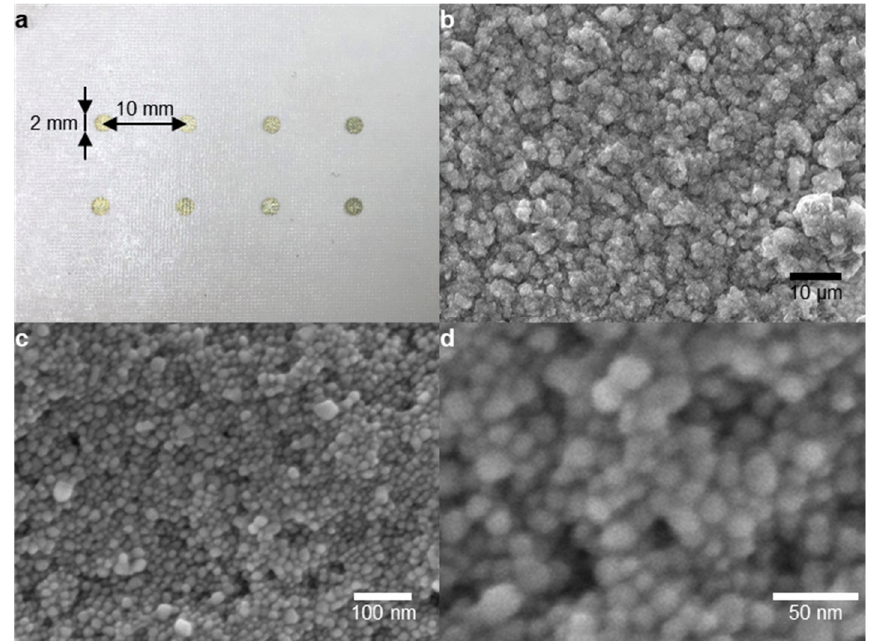
Figure 4. ( a ) Photo of the printed AgNP dot array on tattoo paper; and ( b – d ) SEM images of the AgNP clusters printed on the tattoo paper substrate.